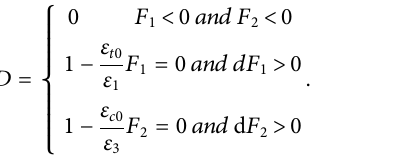
Frontiers in Earth Science |